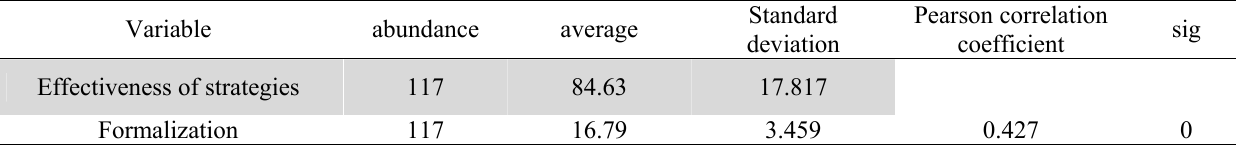
Standard Pearson correlation sig deviation coefficient